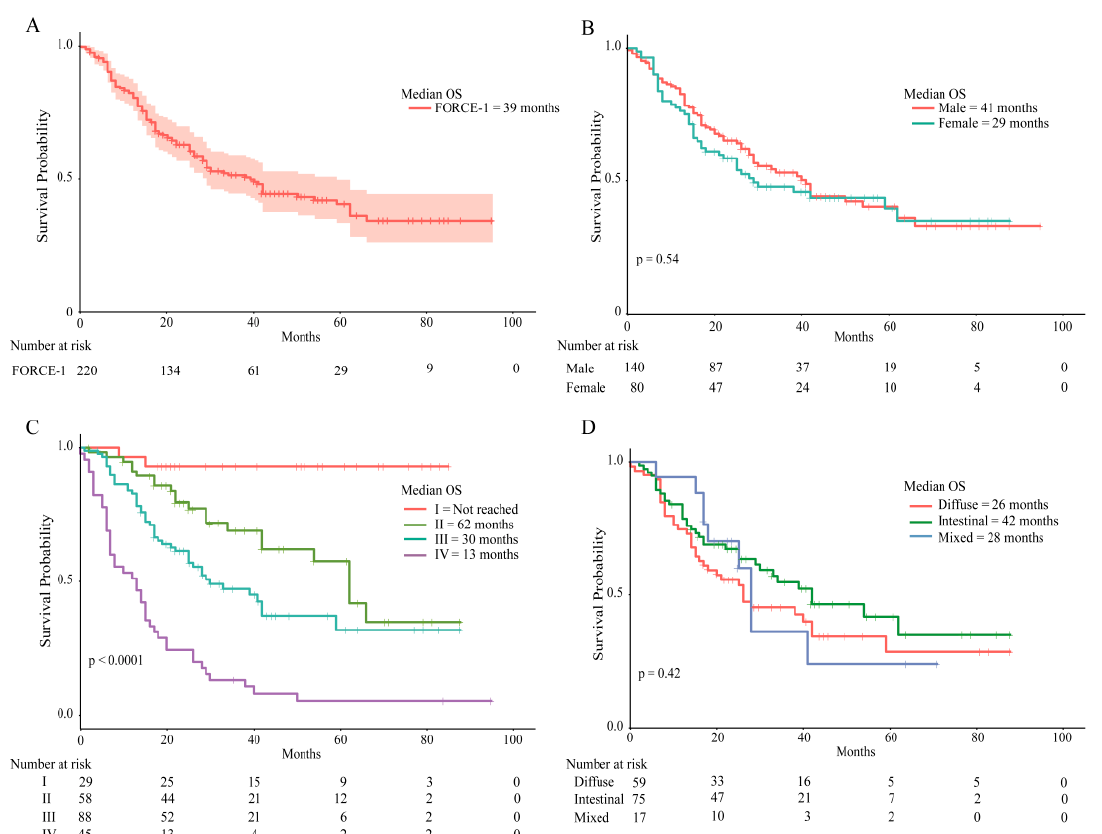
Figure 1. Overall survival rates in the FORCE1 cohort. Kaplan–Meier curves indicate overall survival for ( A ) the entire cohort, ( B ) by gender, ( C ) by cancer stage, ( D ) by histological type.